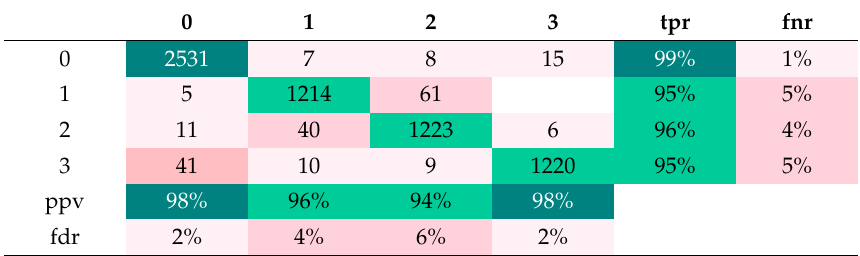
Figure 7. Performance measures (per-unit) corresponding to the quadratic SVM strategy for the multiclass classification problem for a box constraint C = 30 and with respect to the kernel scale γ (horizontal axis). Table 7. Confusion matrix for the quadratic SVM algorithm for the case C = 30 (box constraint) and γ = 1 (kernel